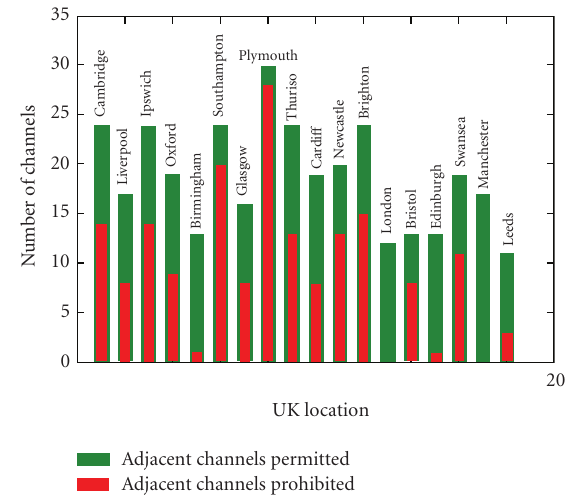
Figure 4: Available TVWS capacity for low-power cognitive access in 18 UK locations as obtained from coverage modelling. Results are shown both without (green bars) and with (red bars) considering adjacent channel interference constraint.